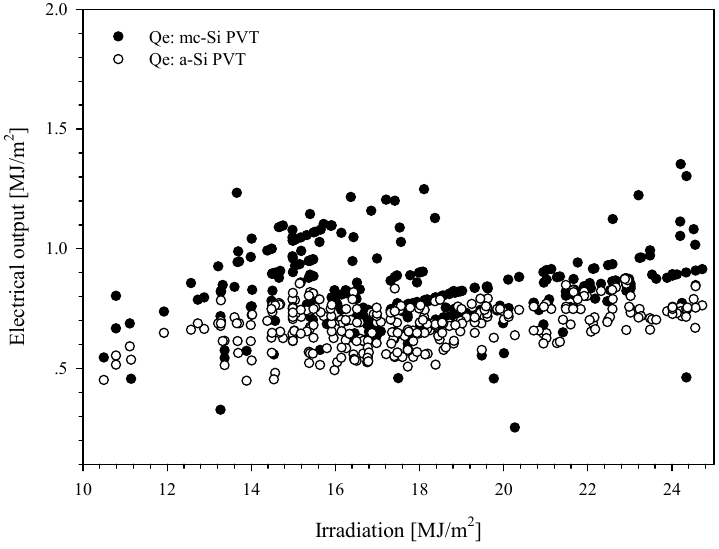
Figure 15. Regression plot between solar irradiation and electrical outputs (data of June are